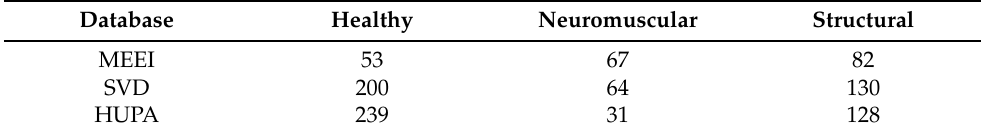
Table 2. Voice samples selected from the pathological voice database. Database